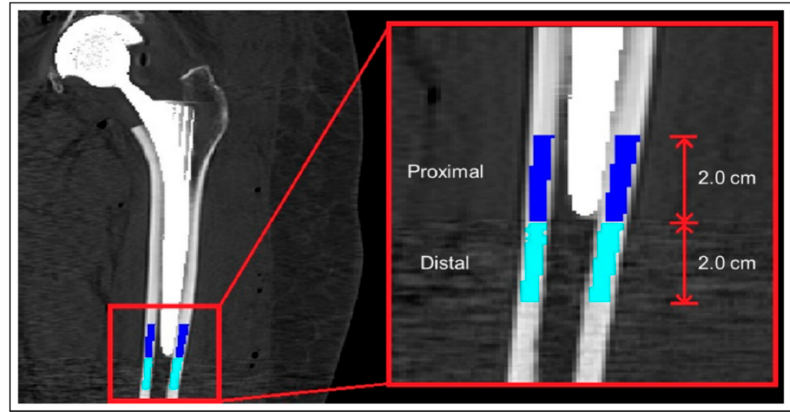
Figure 3. The distal and the proximal regions of the femur bone: the dark blue indicates 2.0 cm of the proximal part of the femur, while the light blue indicates the distal part.